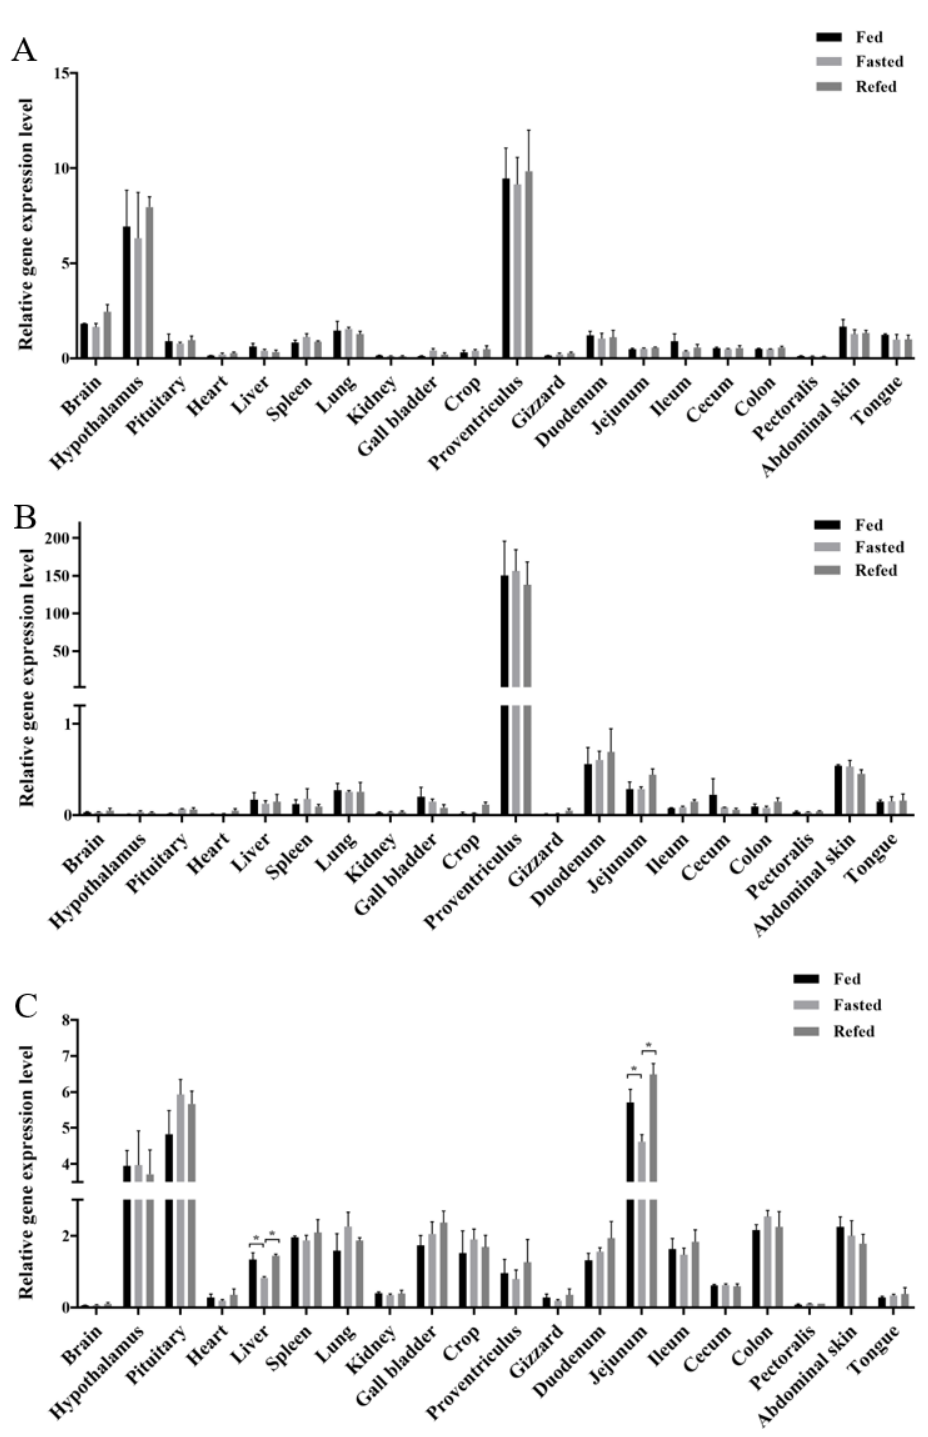
Figure 1. Relative expression levels of GOAT ( A ), ghrelin ( B ), and GHSR ( C ) in the 20 tested tissues of chicks with different energy states (fed, fasted, and refed). GAPDH and HPRT were used as housekeeping genes to calculate the relative gene expression level. Error bars indicate the SE (n = 6). * indicates significant differences ( p ≤ 0.05). Abbreviations: GOAT , ghrelin O-acyltransferase; GHSR , growth hormone secretagogue receptor.